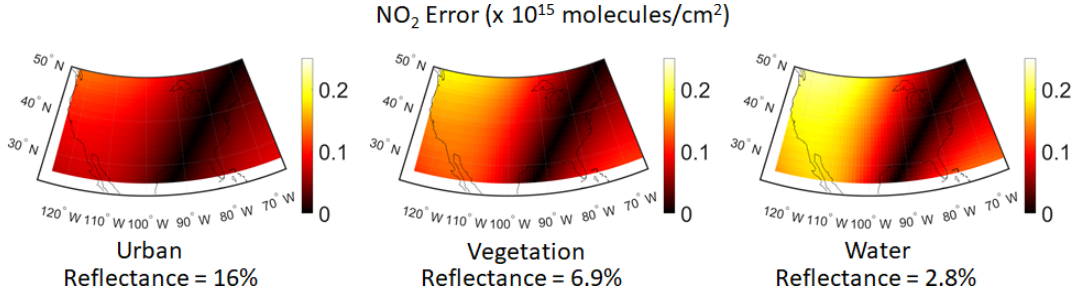
Figure 7. NO 2 errors assuming different scene types across CONUS for 5% PS in a vertical orientation and constant NO 2 profiles with 8 . 4 × 10 15 molec.cm − 2 (see Table 3, Simulation B for more